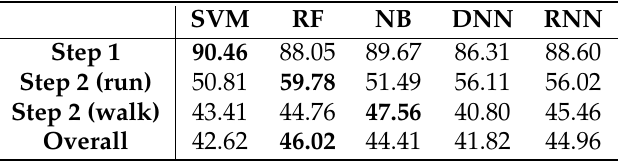
Table 8. Accuracies of action-possession recognition under one-user-out cross validation.